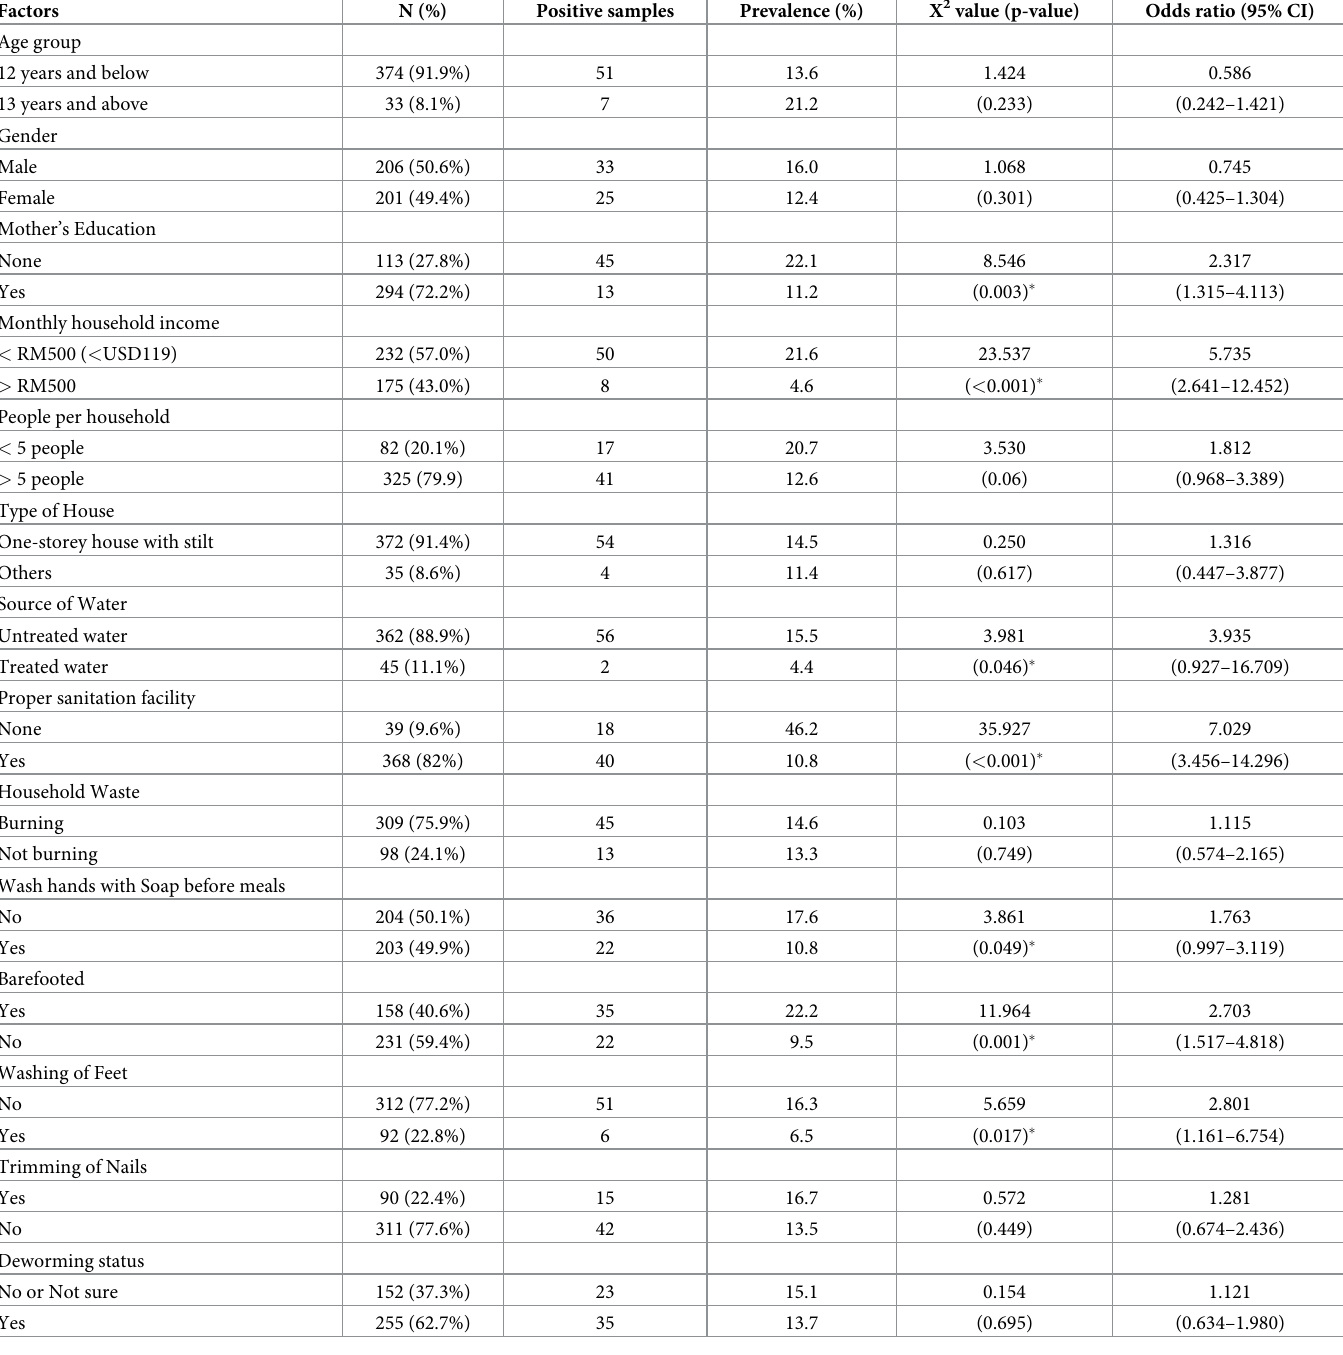
Table 6. Association analysis of factors with geohelminthiasis (univariate analysis). Data based on 407 children in 13 rural villages in Kota Marudu). Missing data were omitted from the